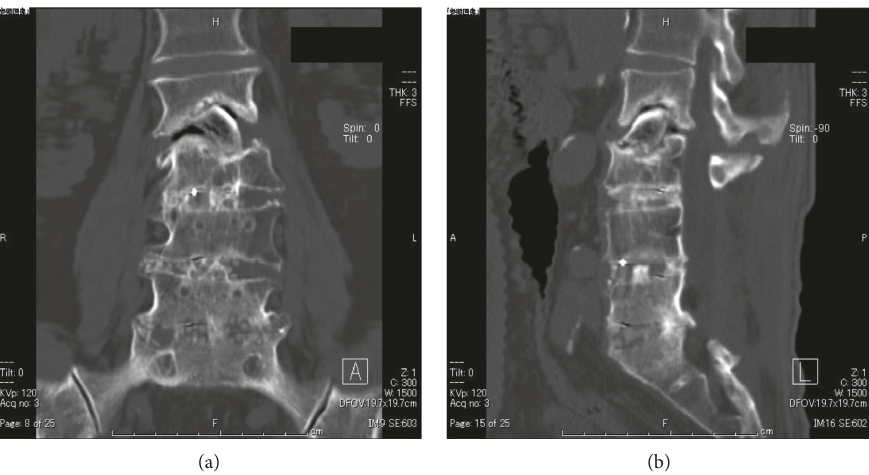
Figure 3: Case 1: coronal (a) and sagittal (b) CT images showed bone union at the L2-3 level 13 months after initial ASF.